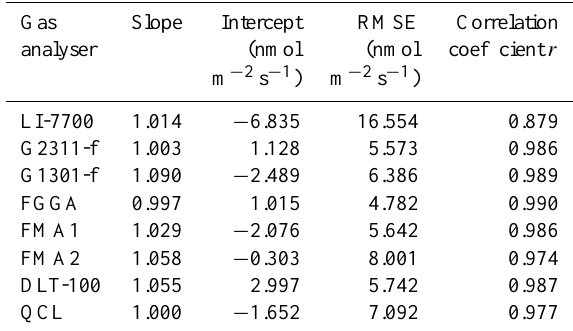
Table 5. Agreement between CH 4 fluxes obtained from different instruments and median CH 4 flux from all instruments. 221 CH 4 flux data points when all instruments were working were used in the analysis. For G1301-f only 139 points were used due to the short operating time of the instrument. Only periods when all CH 4 fluxes had the quality flag 0 or 1 and the difference between sensible heat fluxes from the two anemometers was smaller than 40Wm − 2 were used. LI-7700 data are affected by an external data-logging problem which is not caused by the